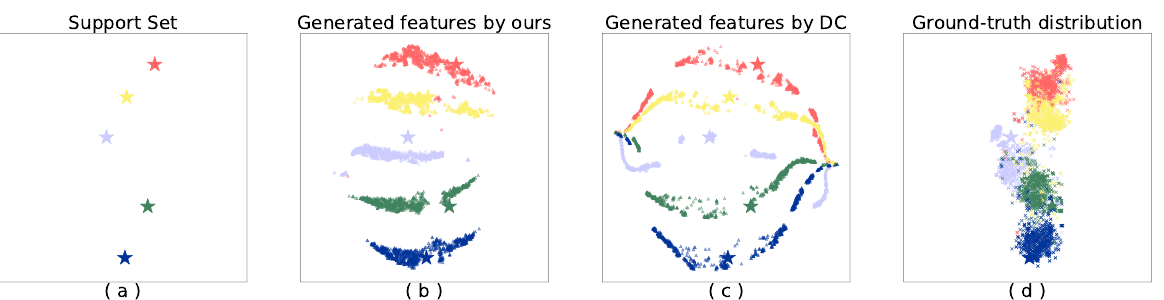
Figure 4. The t-SNE visualization of generated features and ground-truth distributions on a random 5-way-1-shot task sampled from mini ImageNet. (cid:70) in ( a – d ) represents support set features, (cid:78) in ( b , c ) represents the generated features, × in figure ( d ) represents features of ground-truth distributions.